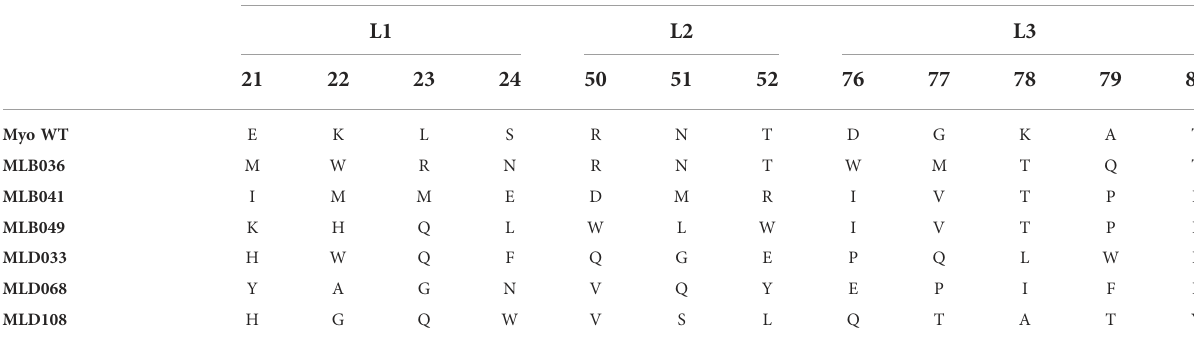
TABLE 1 Sequence comparison for the selected MLB/MLD protein variants. Myomedin